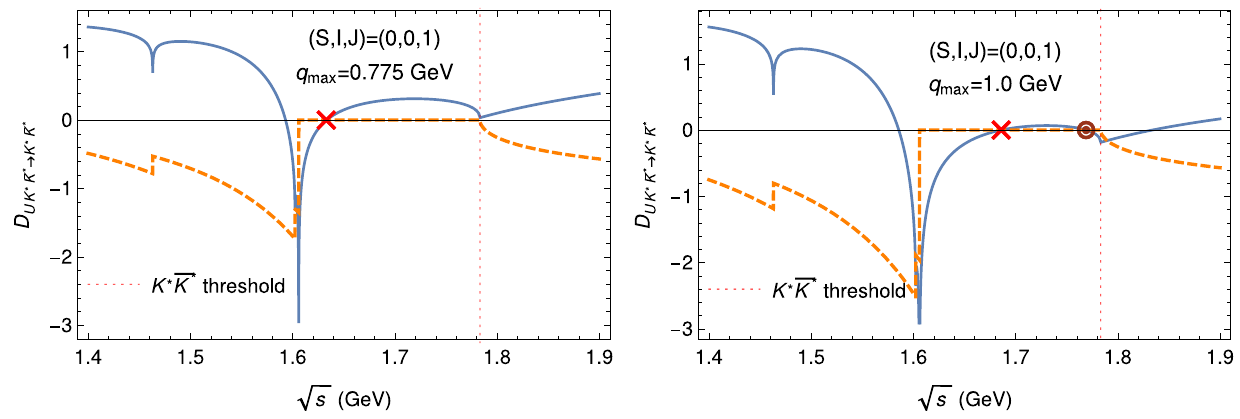
Fig. 4 The D U functions (real part: solid curve, imaginary part: dashed curve) of K ∗ K ∗ → K ∗ K ∗ with ( S , I , J ) = ( 2 , 0 , 1 ) on the real axis of physical sheet (RS-I) and unphysical sheet (RS-II). The artificial pole due to the unphysical left-hand cut is denoted by the red cross